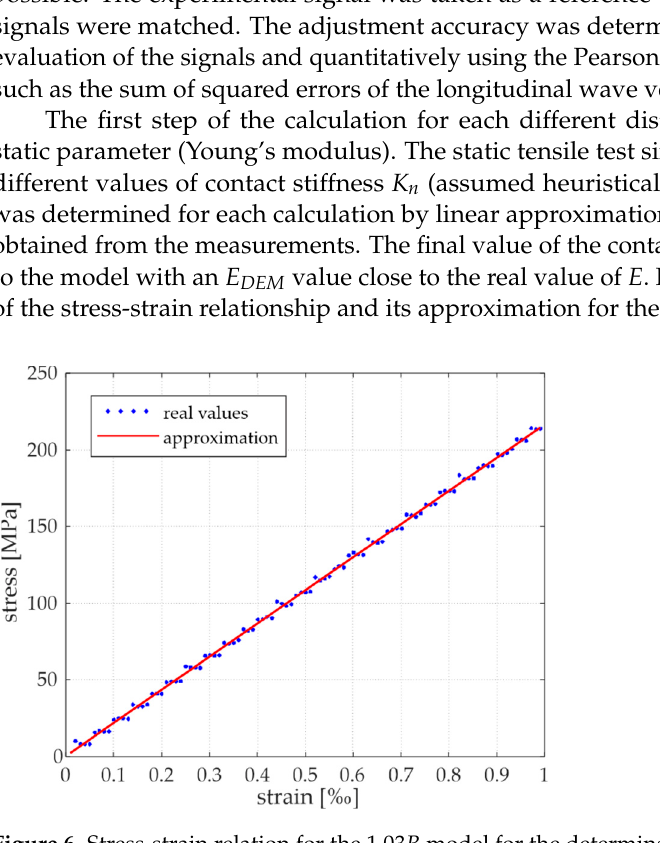
Figure 6. Stress-strain relation for the 1.03 R model for the determination of K n